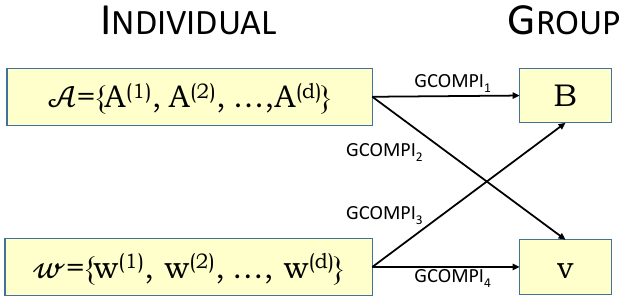
Figure 1. Outline of the GCOMPI